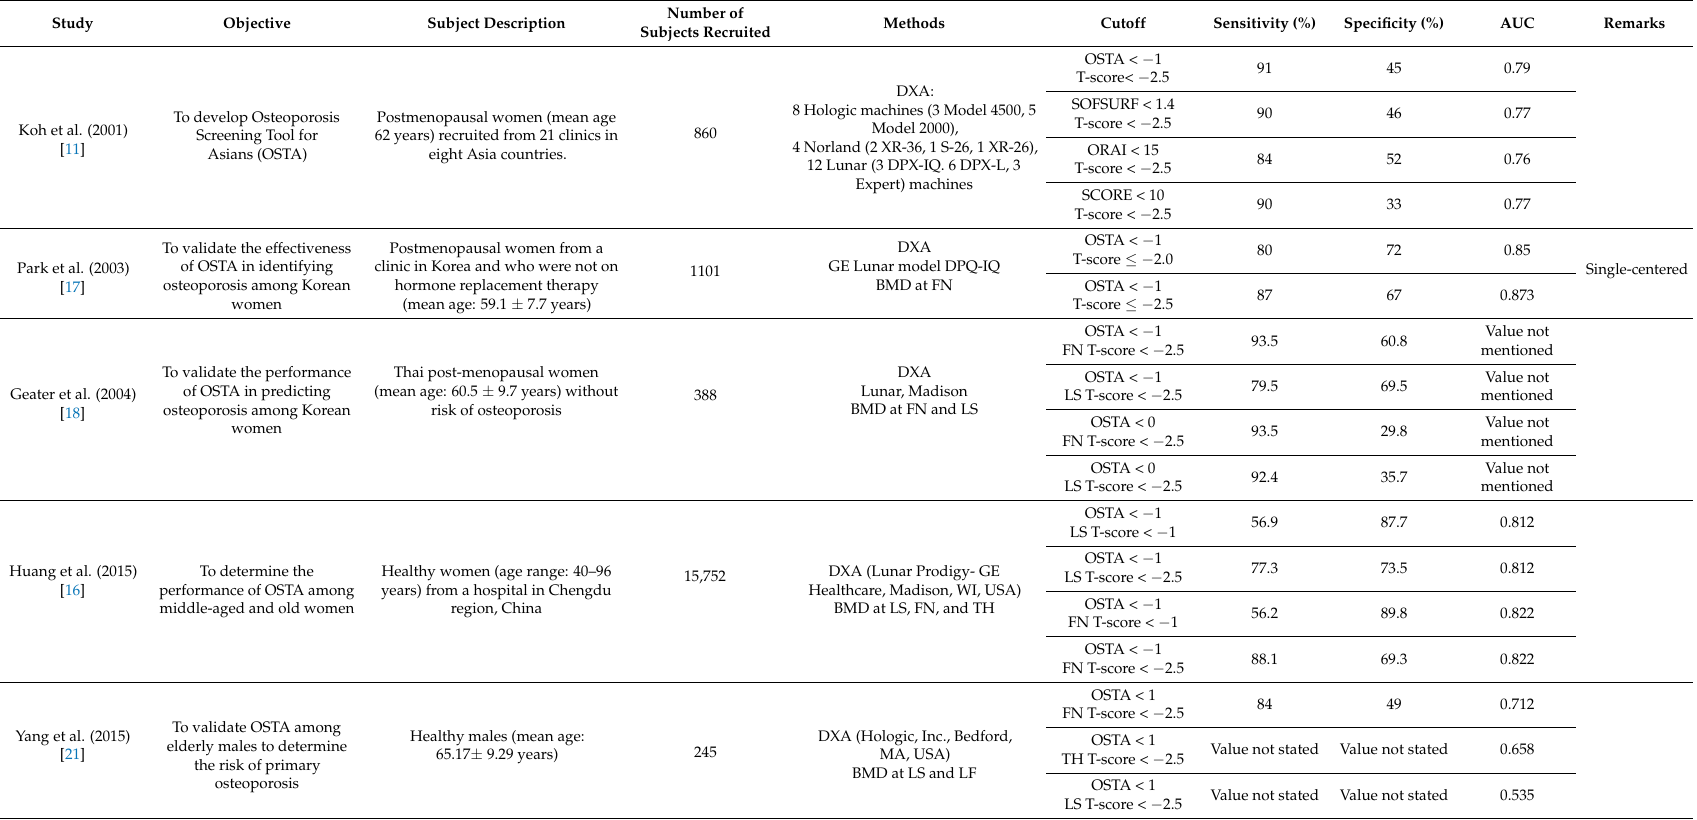
Table 1. Performance of OST among